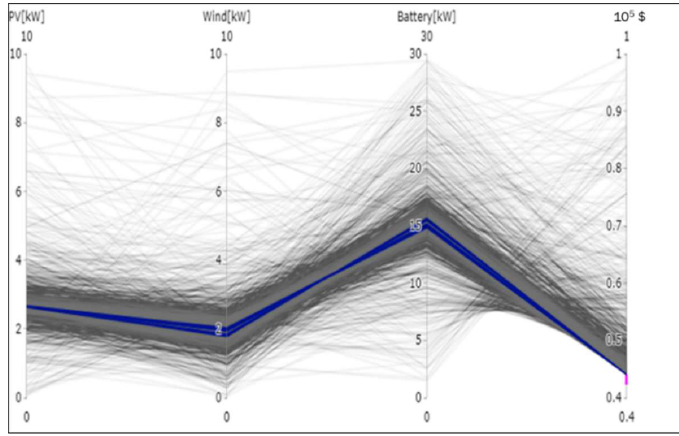
Figure 19. Estimated power output per each unit of PV panel and wind turbine.